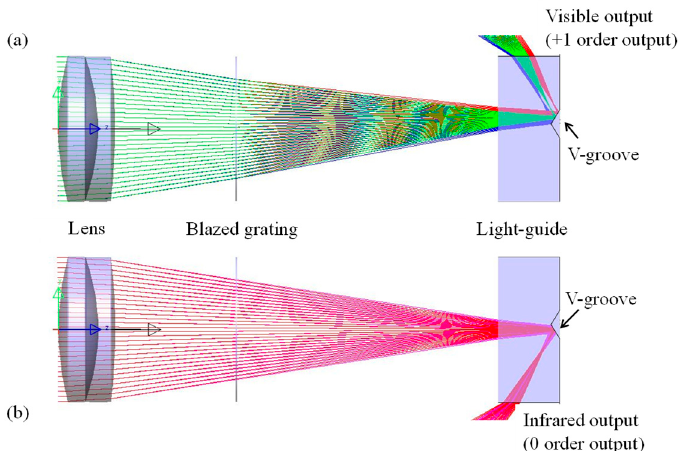
Figure 4. Single unit of the proposed module with the ray-tracing results for ( a ) the first-order and ( b ) the zeroth-order diffractive beams exiting through the visible and the infrared output ports, respectively.